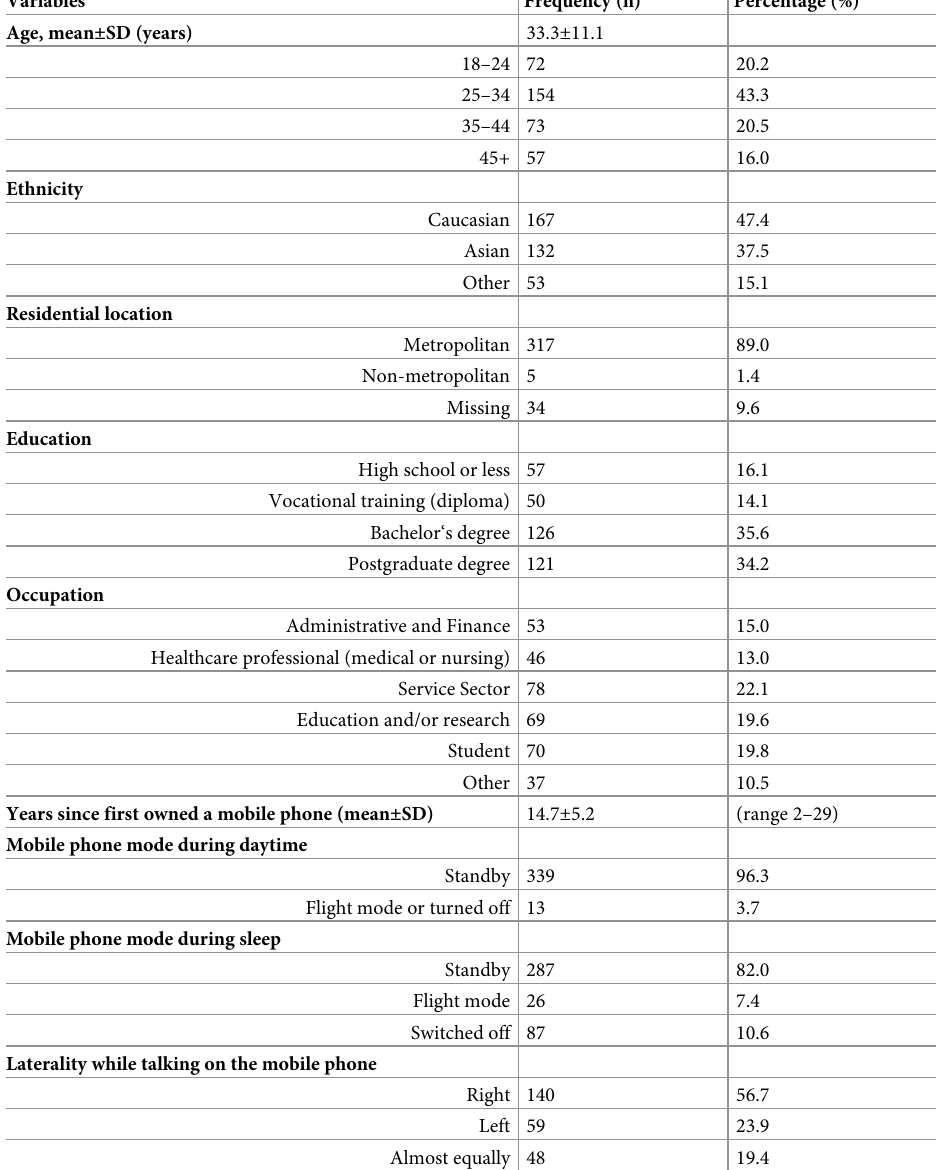
Table 1. Participants’ socio-demographic